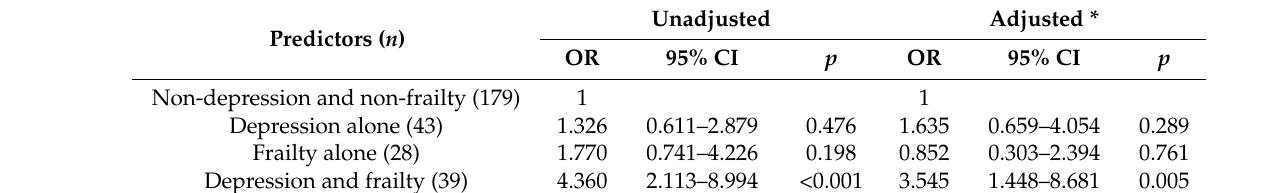
Table 3. Association of depression and frailty with cognitive impairment ( n = 289)